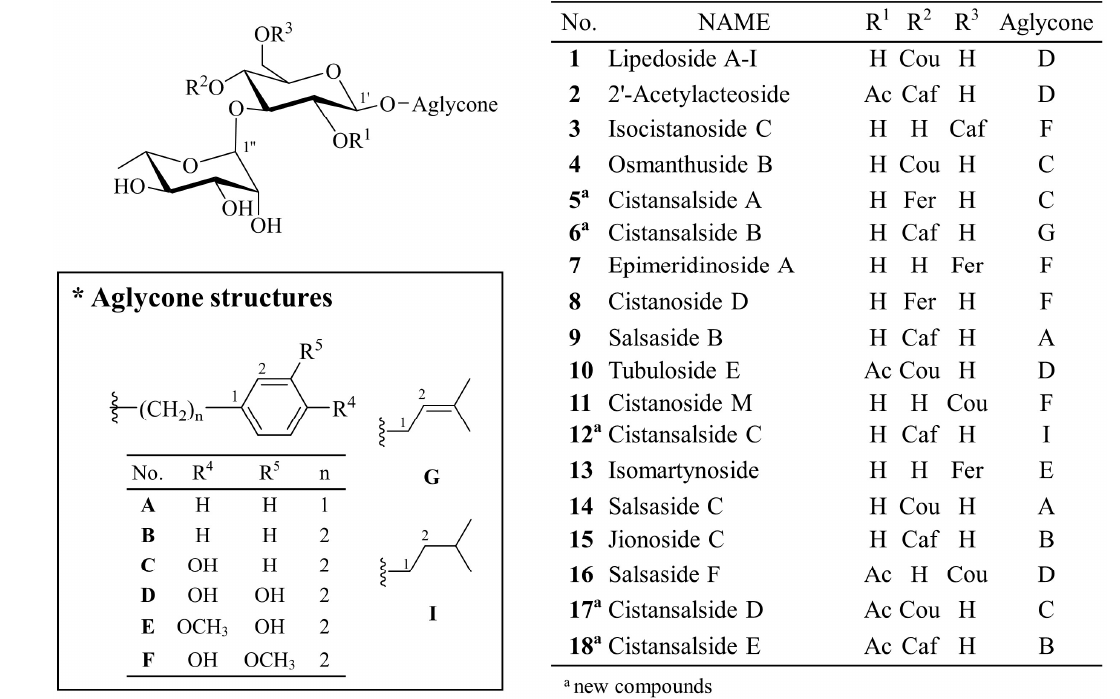
Figure 1. Structures of compounds 1 – 18 .